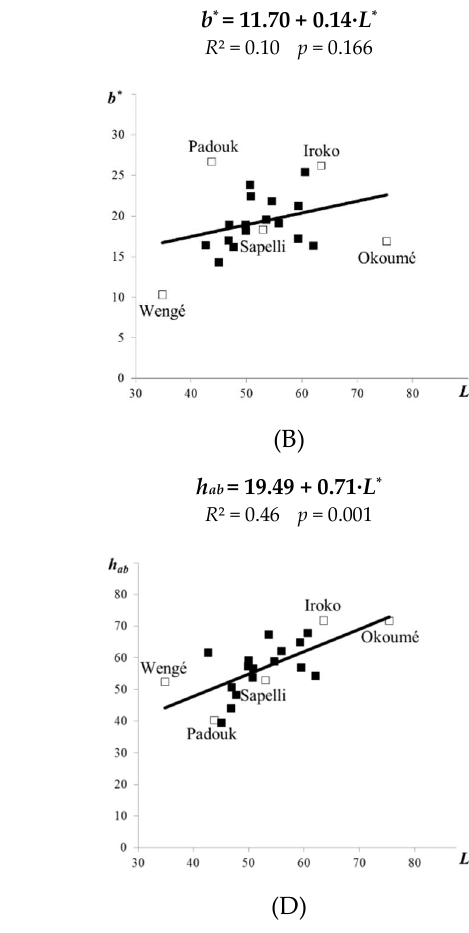
Figure 2. Linear correlations between the lightness L * and the colour coordinates a * , b * ( A, B ), the colour saturation C * ab ( C ), and the hue tone angle h ab ( D )—for 21 original tropical wood species. This result suggests that tropical woods with a dominant yellow shade are usually lighter.